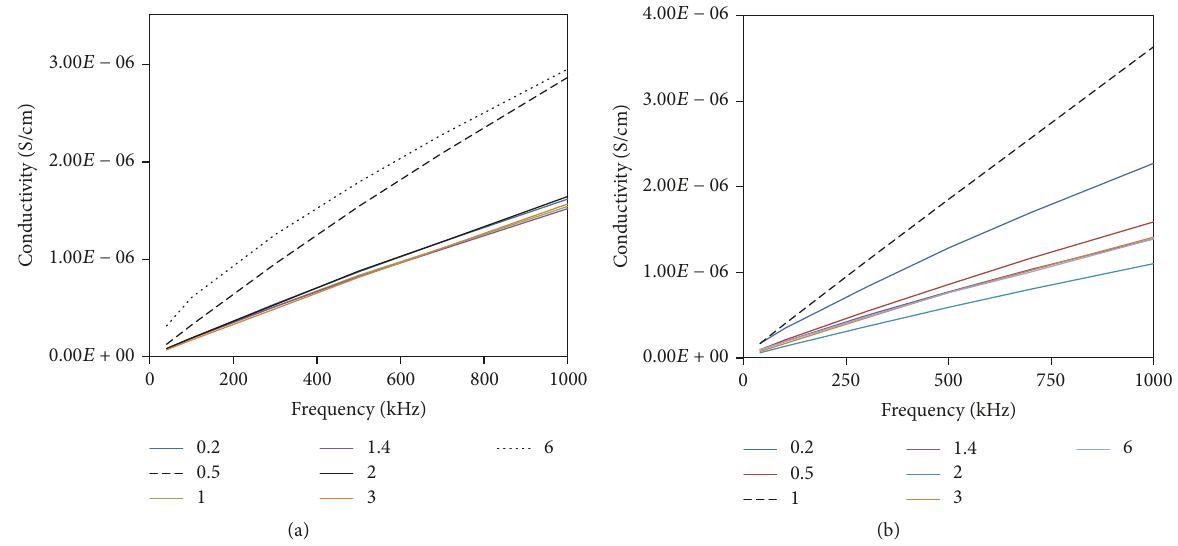
Figure6:Frequencydependenceelectricalconductivityfor(a)DBSA-CoNPs/PMMAand(b)CoNPs/PMMAcompositesfordifferentweight percentage of